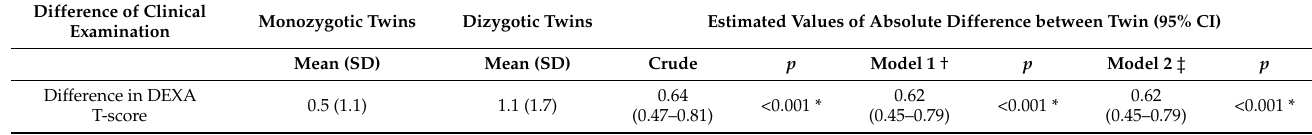
Table 4. Analysis of estimated values of absolute value of difference between the matched twins (reference: absolute value of difference between monozygotic